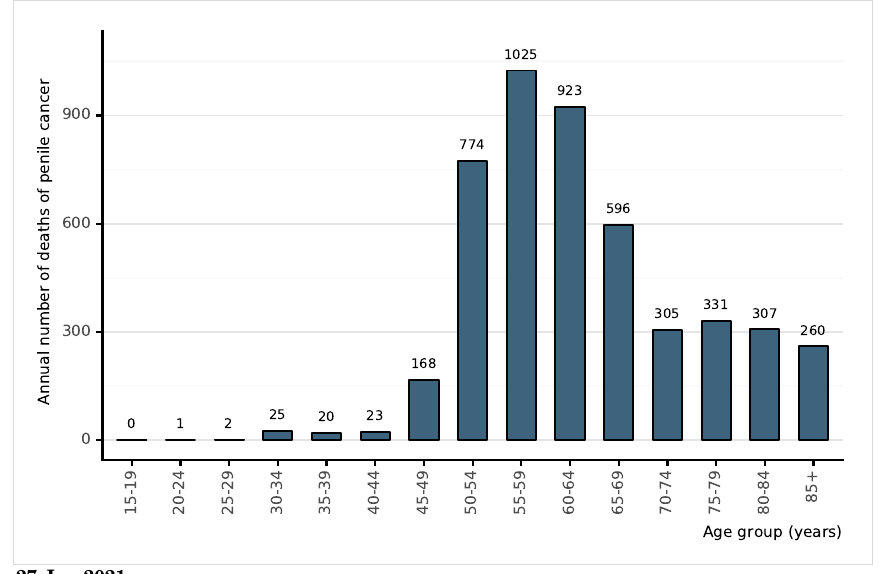
Figure 34: Annual number of deaths of penile cancer in India (estimates for